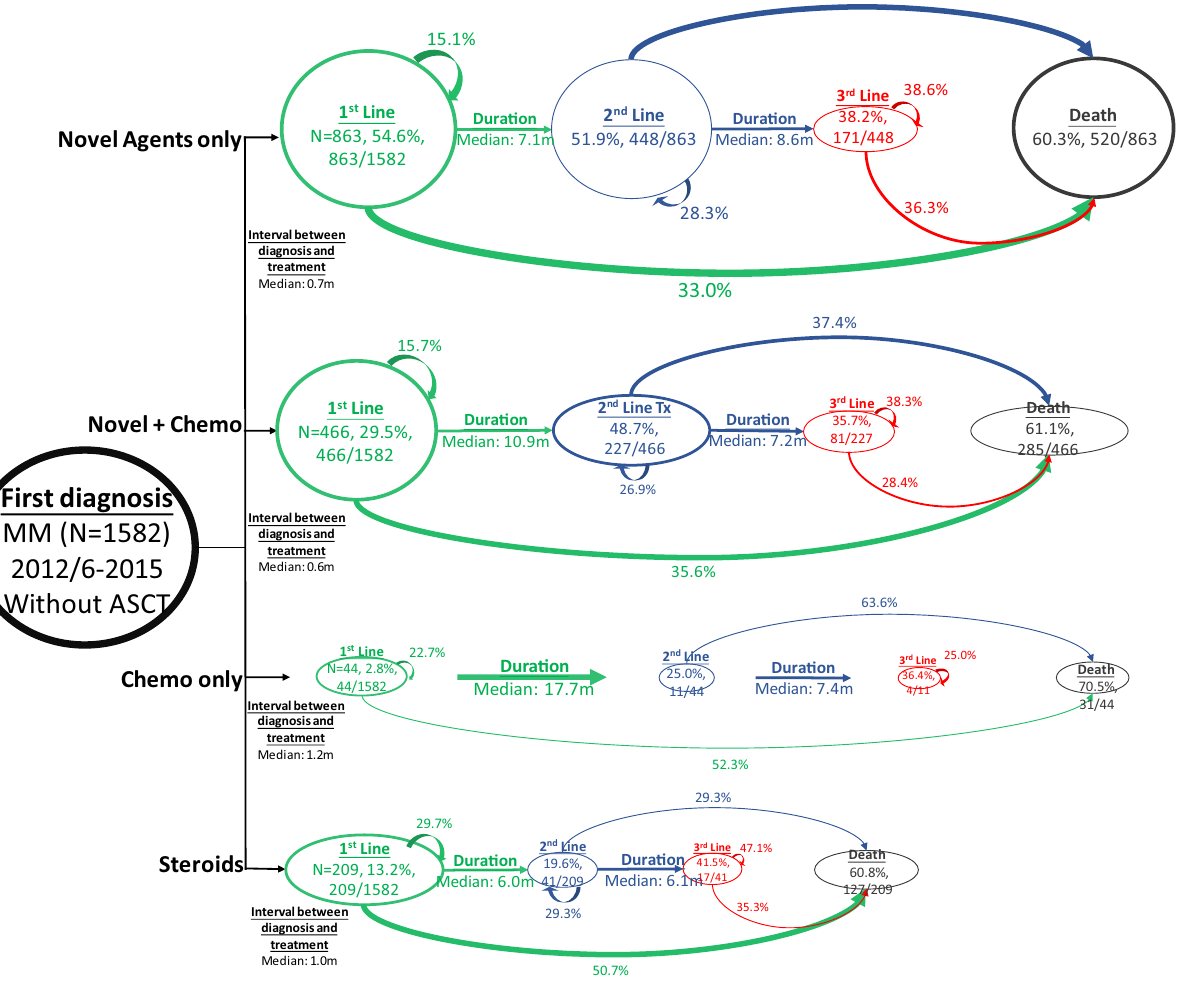
Figure 3. Disease progression model in patients diagnosed with MM in the post-bortezomib period who did not receive ASCT. The DPMs illustrate the percentage of patients who moved from first-line, to second-line through to the end of third-line treatment according to the type of first-line therapy received and includes those who died or received ASCT during their disease journey. Arrows that return to the line of therapy indicate patients who stayed on the line of therapy for the study duration. Arrows to ‘Death’ indicate the percentage of patients who died at each treatment line. Duration refers to the gap between commencement of one line of therapy and the next. The figures (lengths, widths, areas etc.) are directly proportional to the numbers displayed. ASCT autologous stem cell transplant, MM multiple myeloma, Tx